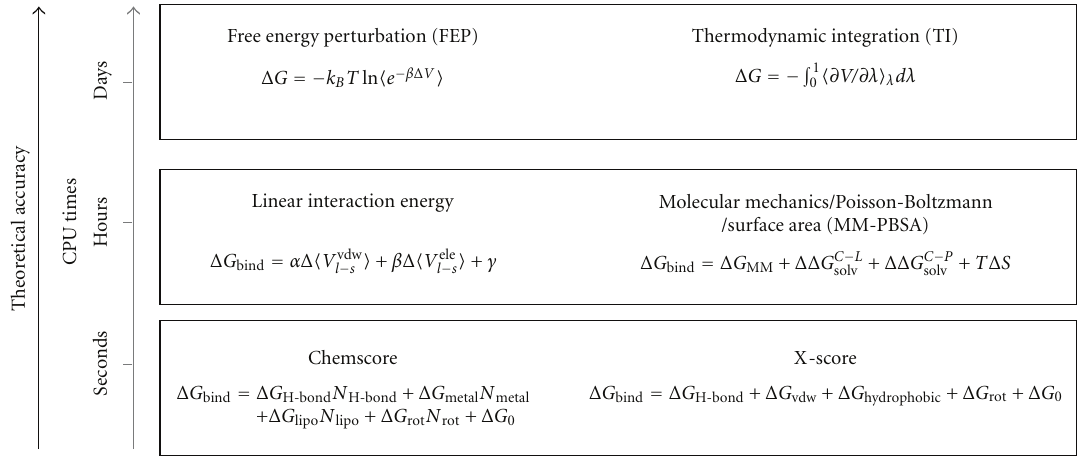
Figure 4: Theoretical approaches used to calculate the binding free energy of protein-inhibitor complexes. The arrows show the correlation between theoretical accuracy of methods and the computational time required to perform the